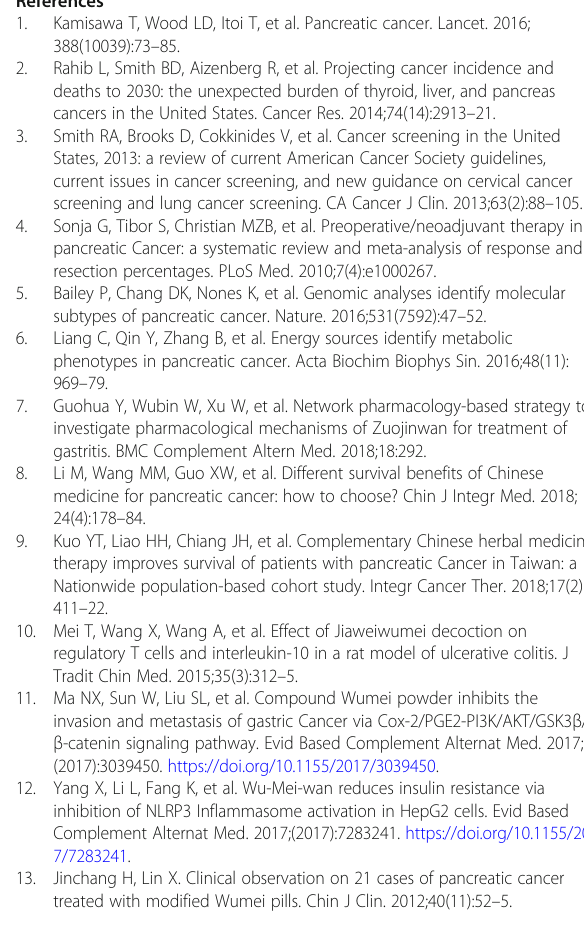
Additional file 1: Table S1. Active ingredients and ADME parameters of Wumei Pill (DOCX 890 kb)